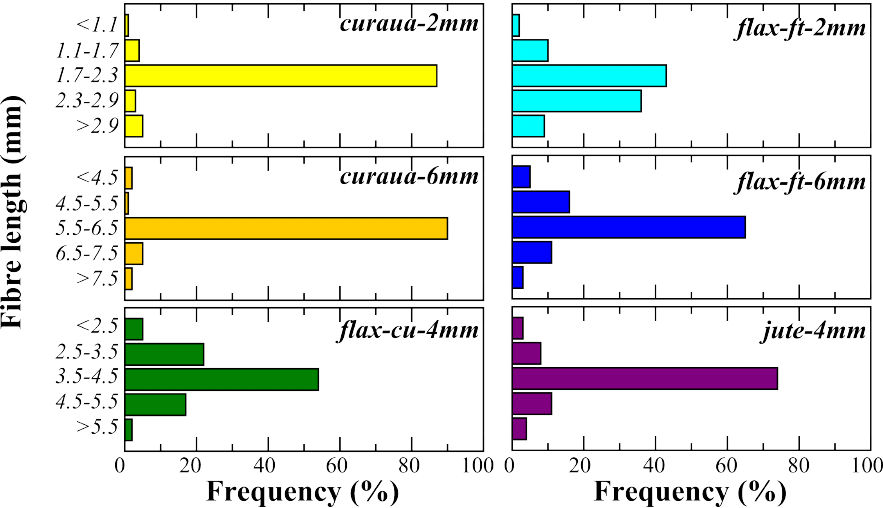
Figure 5. Fibre length distributions of the selected groups of natural